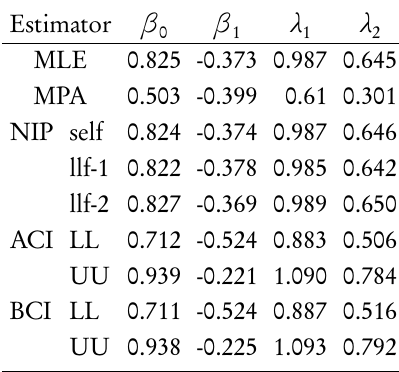
Point and interval estimates of model